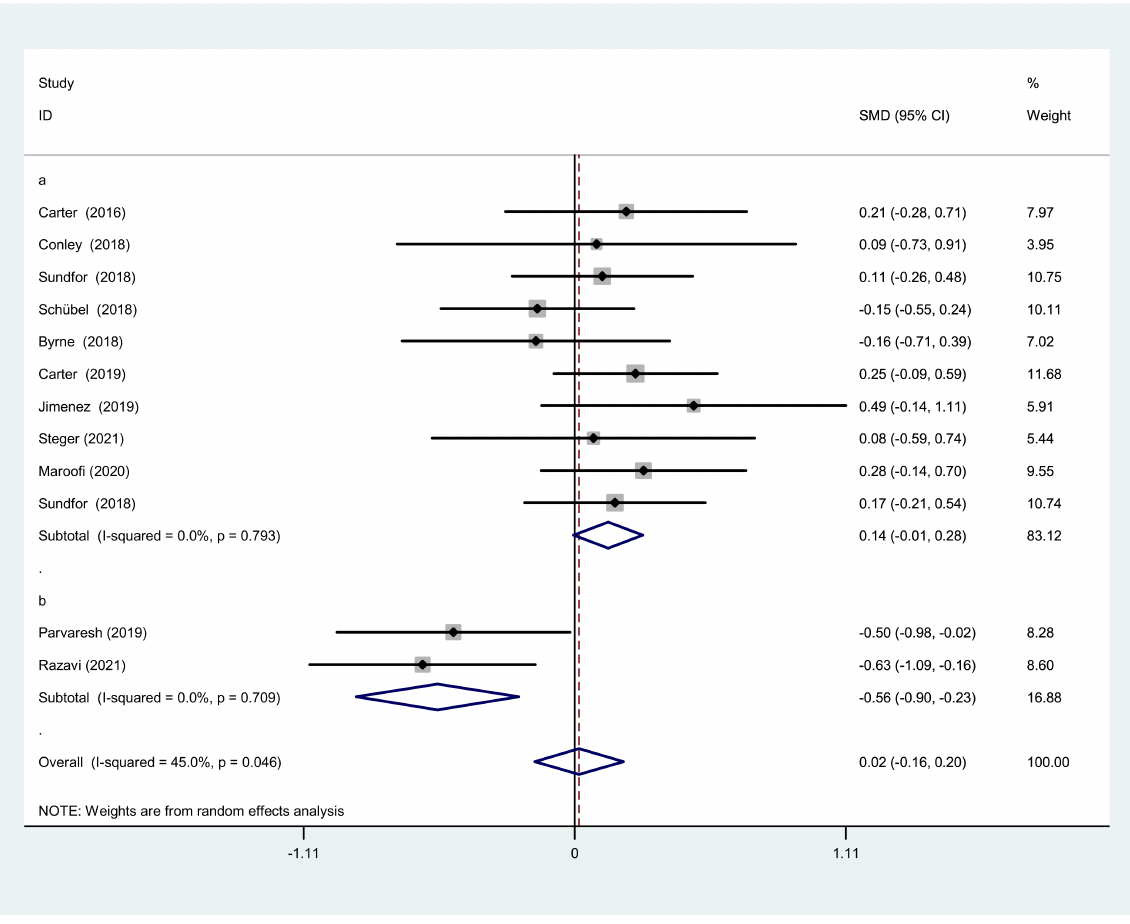
Figure 9. Forest plot of BMI changes after IF and CCR interventions based on fasting days. ( a ) Normal intermittent fasting (calorie restriction is usually two days per week). ( b ) Modified alternate-day fasting (a very lowcalorie diet (75% energy restriction) during the three fast days). Table 3. Subgroups analyses of comparison of IF and CCR based on BMI